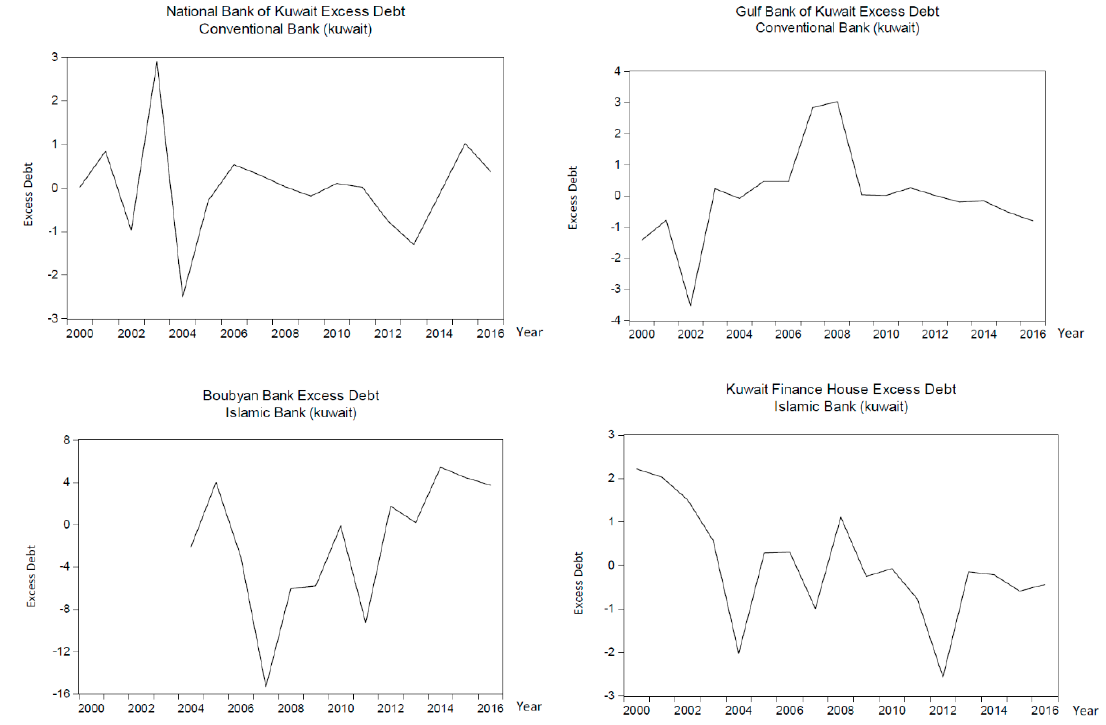
J. Risk Financial Manag. 2020 , 6 , x FOR PEER REVIEW Figure 7. Kuwait excess debt. Source: Author’s calculations. Figure 7. Kuwait excess debt. Source: Author’s calculations.